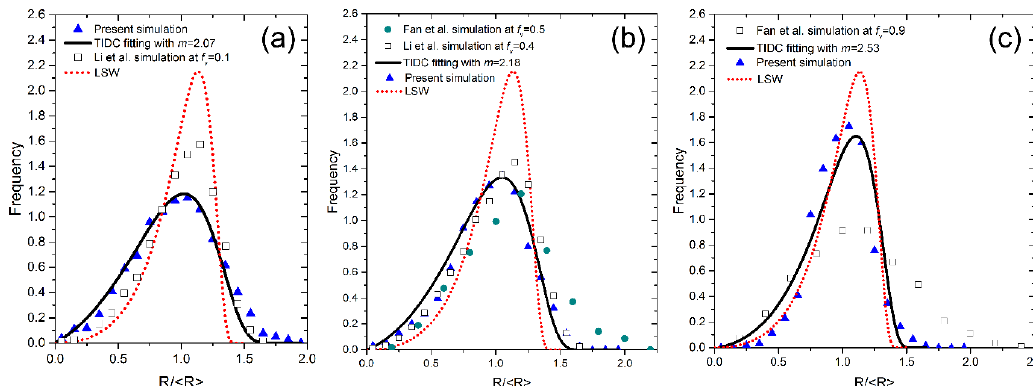
Figure 7. Comparison of the (near) steady state PSDs of the present results with the simulation results by Li et al. [12], Fan et al. [10] and the prediction of LSW theory at the volume fraction of ( a ) 10%; ( b ) 50%; ( c ) 90%. The solid lines are the theoretical PSDs of the TIDC theory with different m values that best fit with the present simulation results. PSD: particle size distribution; LSW: Lifshitz, Slyozov and Wagner; TIDC: trans-interface-diffusion-controlled.